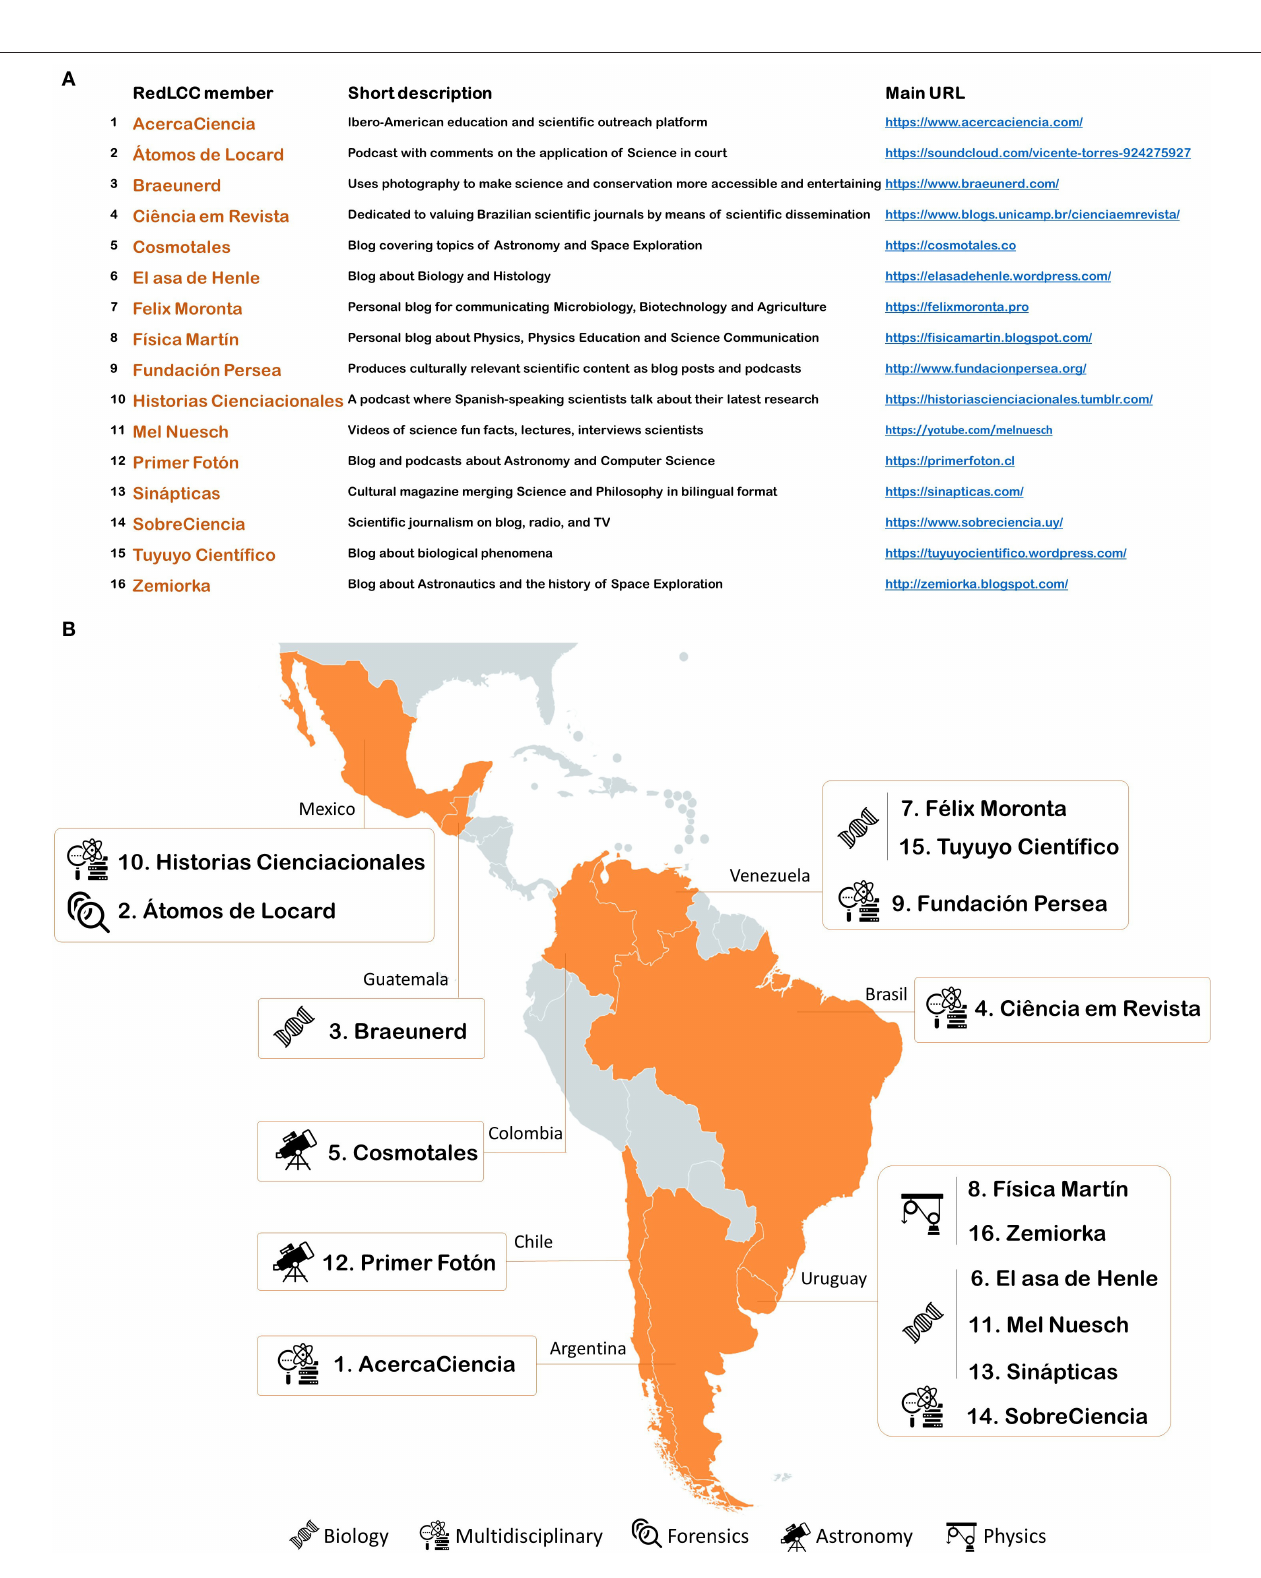
FIGURE 1 | The Latin American Network for Scientific Culture (RedLCC). (A) List of the 16 members that compose the Network, in alphabetical order, by December 2020. A brief description of each one and the URL for accessing their content are shown. (B) The geographical origin of each of the initiatives with their scientific